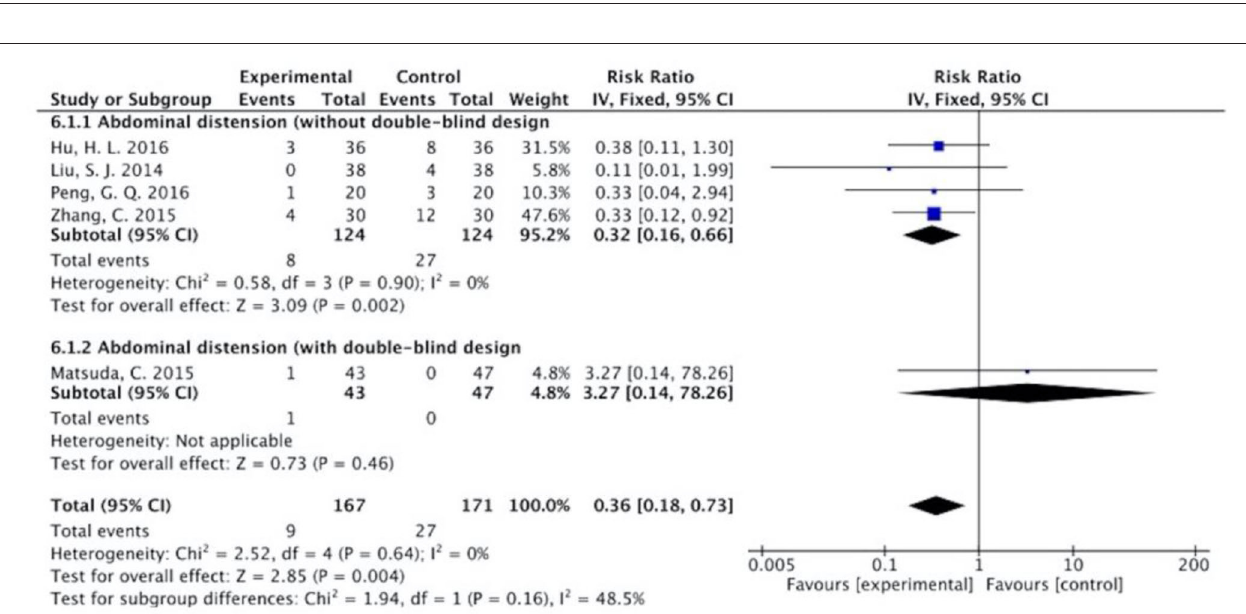
FIGURE 12 | Sub-analysis on the effect of herbal medicine in abdominal pain in chemotherapy-induced toxicity.